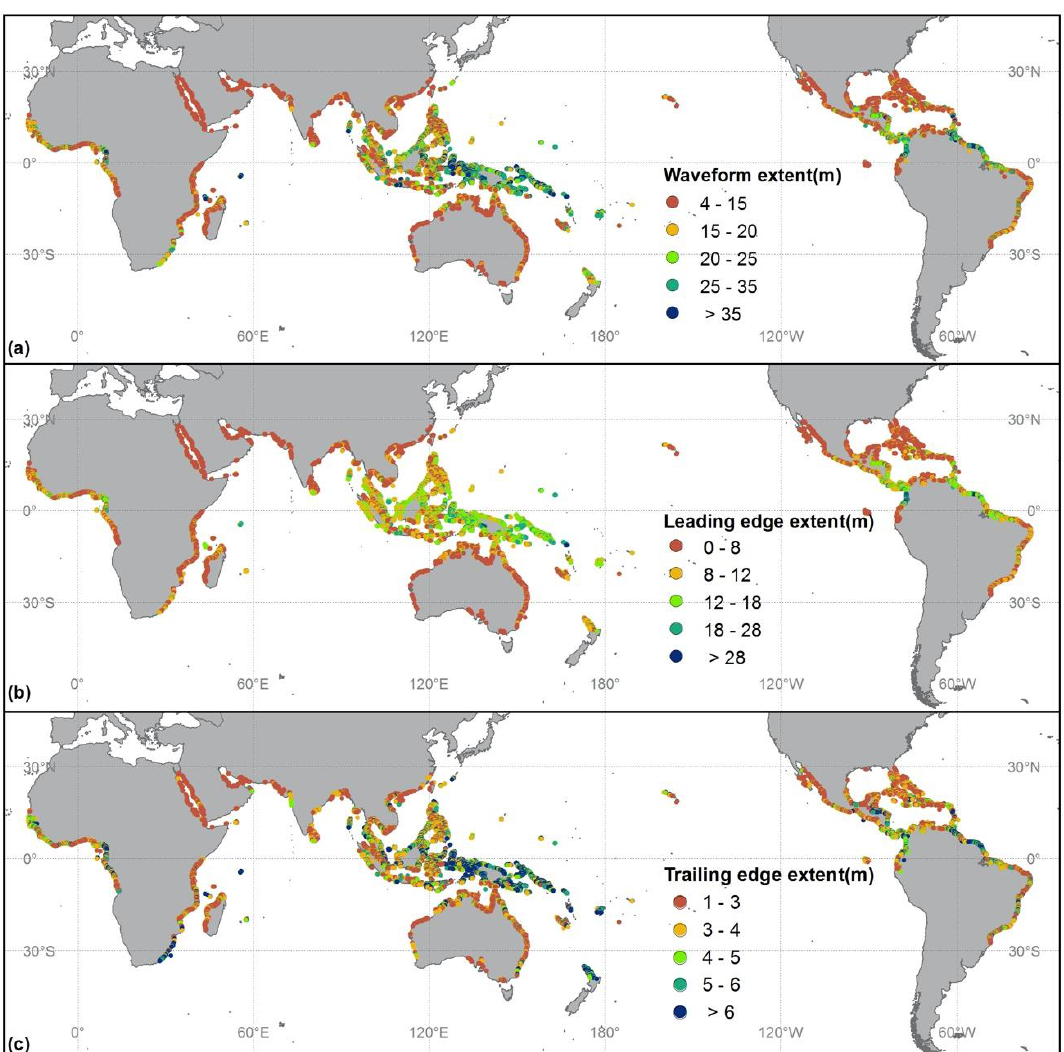
Figure 3. The spatial-continuous map of three GLAS parameters in the mangrove distribution zone, ( a ) waveform extent, ( b ) leading edge extent, and ( c ) trailing edge extent. Note that the spatially continuous map was drawn using points since the mangrove distribution zone is narrow and cannot be represented well using a raster map at the global scale.